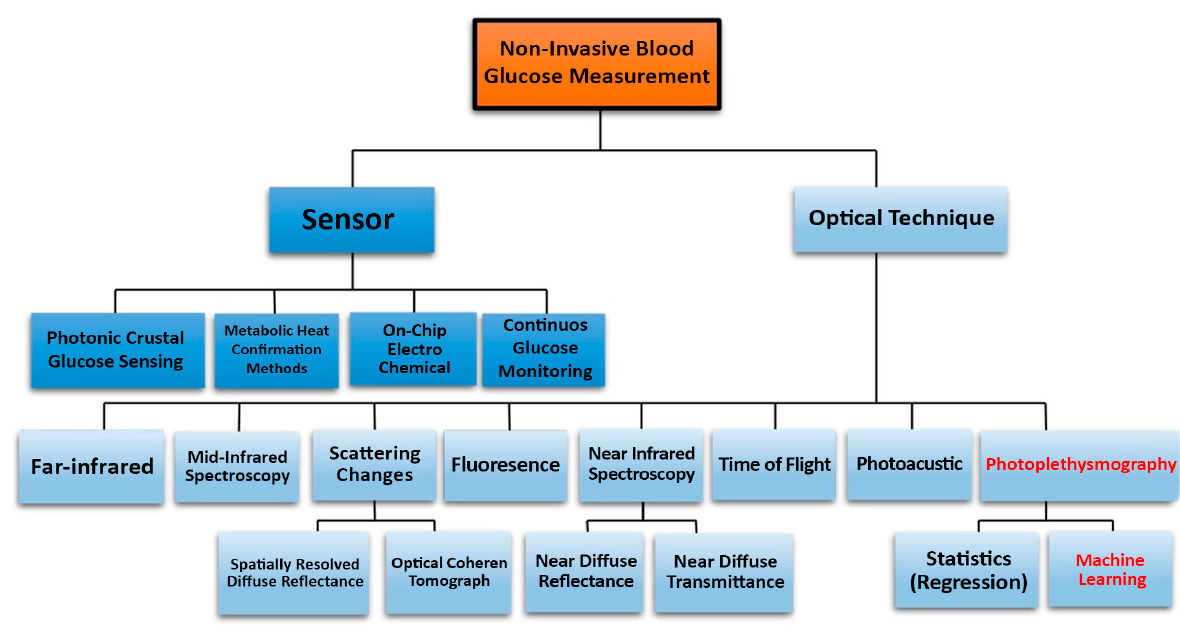
Figure 1. Non-invasive blood glucose measuring methods.